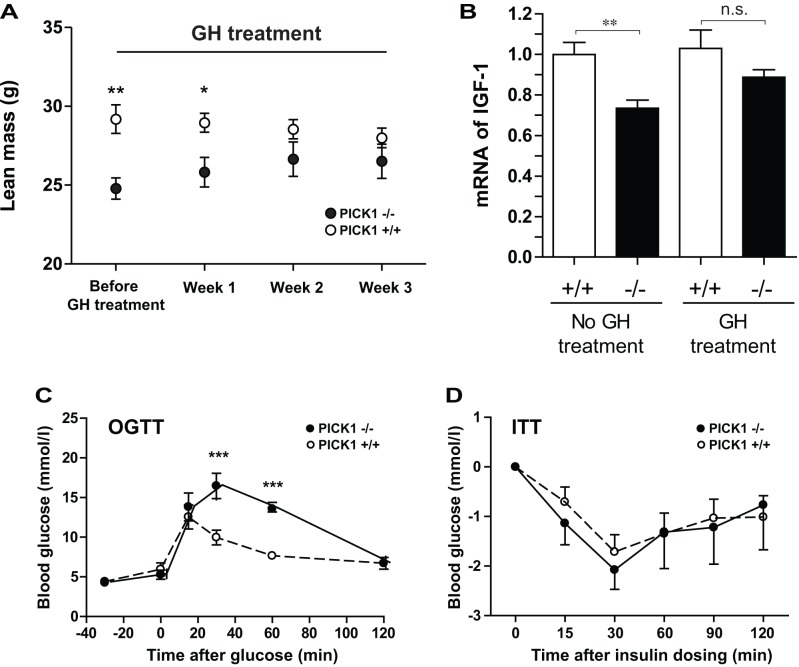
Rescue of the phenotype of PICK1-deficient mice by GH administration.(A) Lean body mass was evaluated by MRI scanning before GH administration and subsequently once every week both in PICK1-deficient mice (black squares) and in saline-treated WT littermates (white circles). Before treatment the difference between the two groups was highly significant (**p = 0.0027), after a week the difference decreased but was still significant (*p = 0.050), and after 2 and 3 wk no significant difference were observed. (B) IGF-1 mRNA level in the liver as determined by RT-PCR was significantly lower in PICK1-deficient mice compared to untreated mice (*p = 0.0045), however this difference was not observed after GH-treatment for 3 wk. (C) OGTT and ITT on GH-treated PICK1-deficient mice (black circles) and the saline-treated WT littermate controls (white circles). Significant difference was observed in the OGTT, whereas no difference was observed in ITT. Data are expressed as mean ± SE and analyzed by two-way ANOVA in (A) and Student's t test in (B–D) (n = 4–8 in all the experiments). All experiments have been reproduced in another cohort of mice (n = 3–4), where the age of the mice was 4 wk higher.